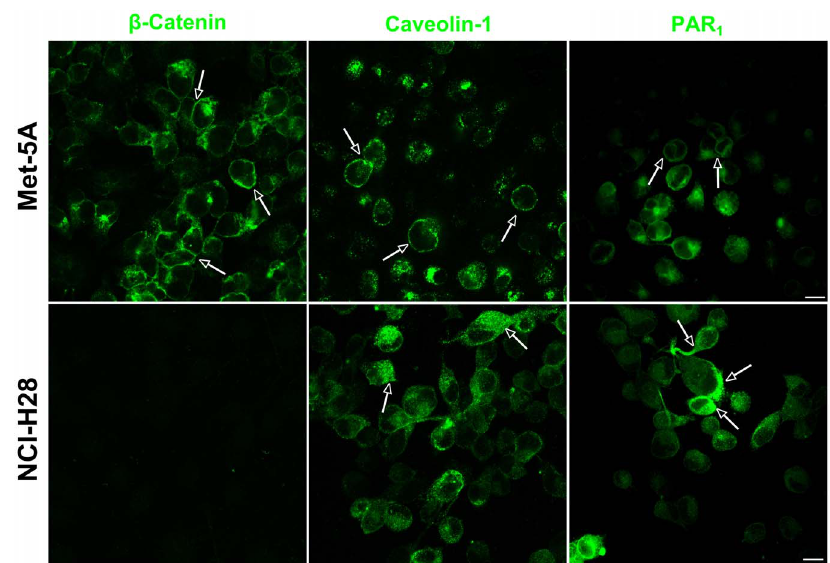
Figure 7. Cellular distribution of caveolin-1 and PAR 1 in Met-5A and NCI-H28 cells. Immunolabeling of b -catenin, caveolin-1 and PAR 1 in Met-5A and NCI-H28 cells was performed as described in Materials and Methods. The images shown are representative of many cells examined in two independent experiments. The arrows point out intracellular or plasma membrane localization of immunostained proteins. Scale Bar: 10 m m.